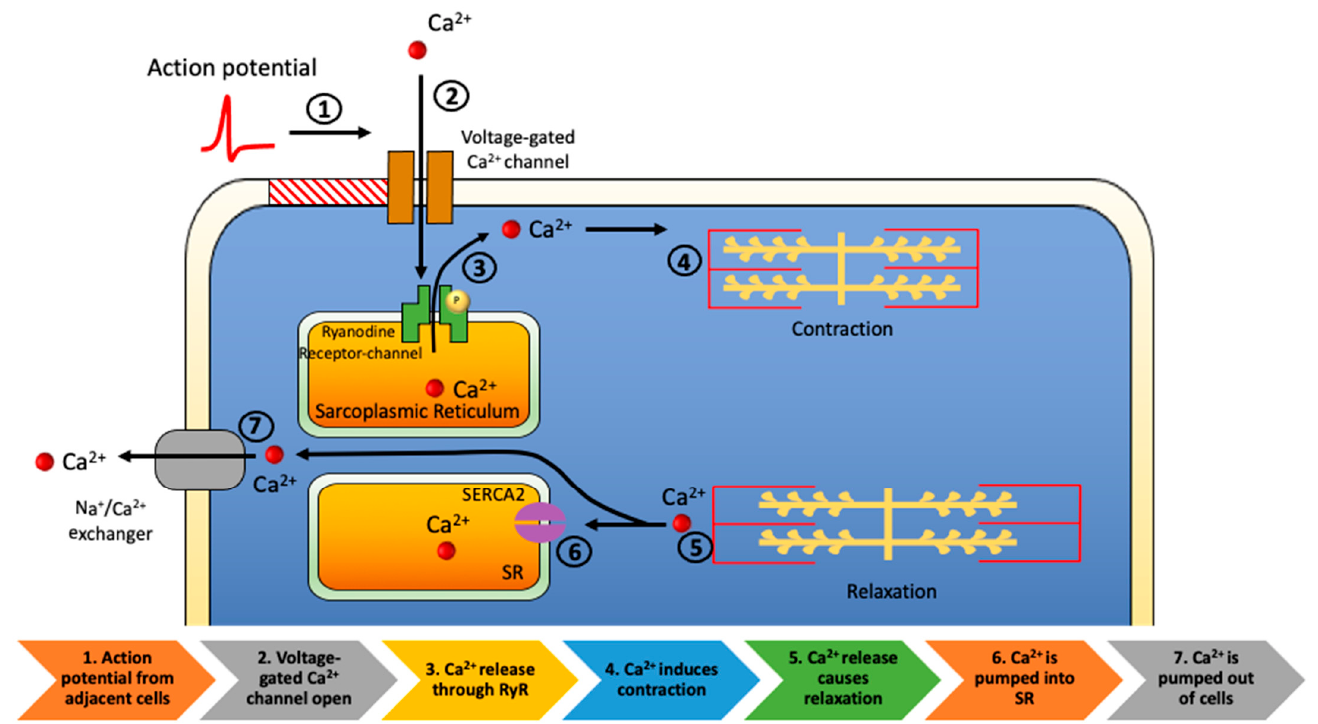
Figure 2. Cardiac excitation-contraction coupling: Action potential transmits directly from adjacent cells (step 1). Calcium enters cardiomyocyte through voltage-gated L-type Ca 2+ channels (step 2). The initial influx of Ca 2+ stimulates efflux of Ca 2+ from ryanodine receptor type-2 channels on the sarcoplasmic reticulum (step 3) resulting in contraction of the heart (step 4). As the contraction ends (step 5), the Ca 2+ reuptake is completed by sarcoplasmic/endoplasmic reticulum Ca 2+ -ATPase 2a (SERCA2a) (step 6). The sodium-calcium exchanger removes Ca 2+ from cells (step 7).